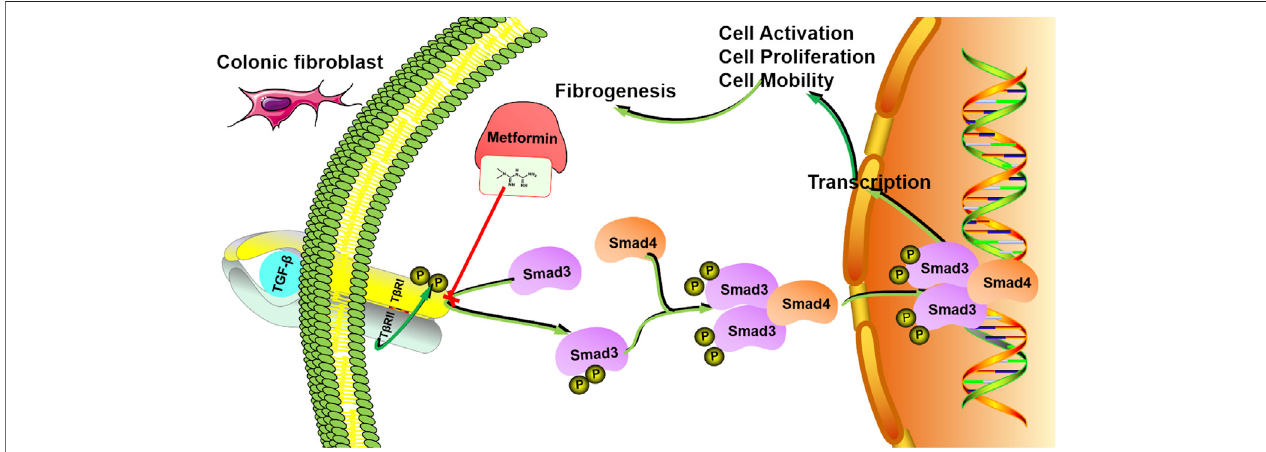
FIGURE 8 | The mechanism model involved in the inhibitory effects of metformin in human intestinal fi brosis. Metformin suppresses the interaction between T β RI and Smad3 signaling in fi broblasts, leading to inhibition of cell activation, proliferation and mobility, fi nally inducing anti- fi brotic effects.